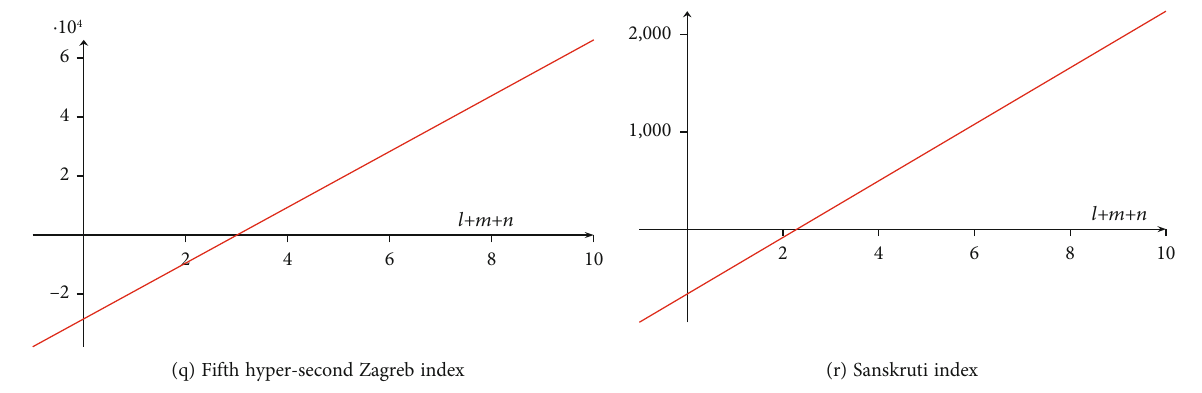
Figure 3: Neighborhood topological indices of St